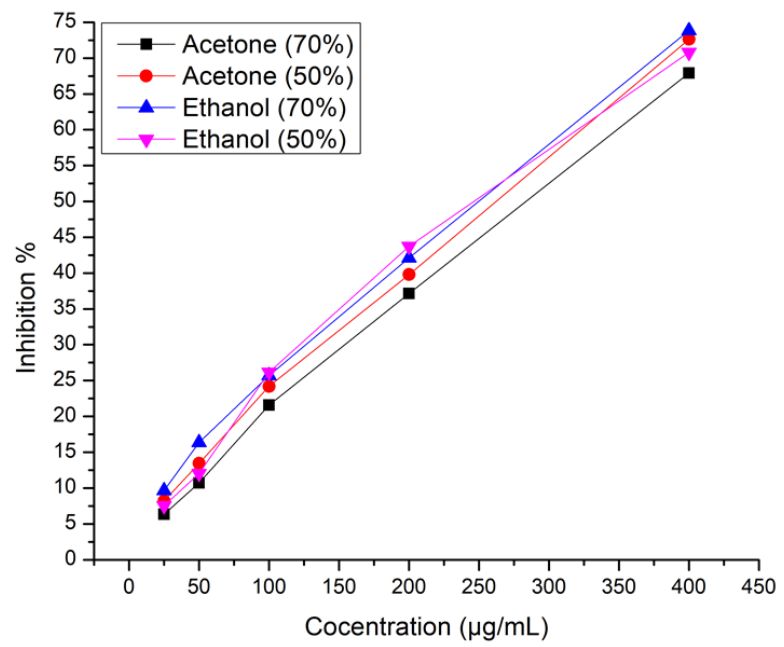
Figure 3. DPPH Radical Scavenging Activity of Lemongrass leaves extracts by sonication technique.